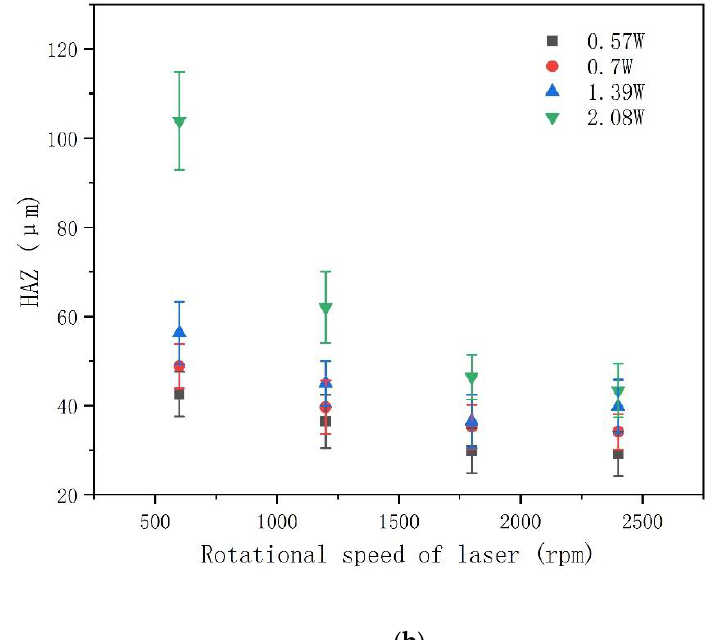
Figure 3. Effect of power/rotational speed on ( a ) ablation depth and ( b ) HAZ using circular laser drilling trajectories. Repetition rate: 50 KHz; powers: 0.57 W, 0.7 W, 1.39 W, and 2.08 W; number of passes: 25 passes; diameter: φ678 um; rotational speed of laser: 600 rpm, 1200 rpm, 1800 rpm, 2400 rpm.